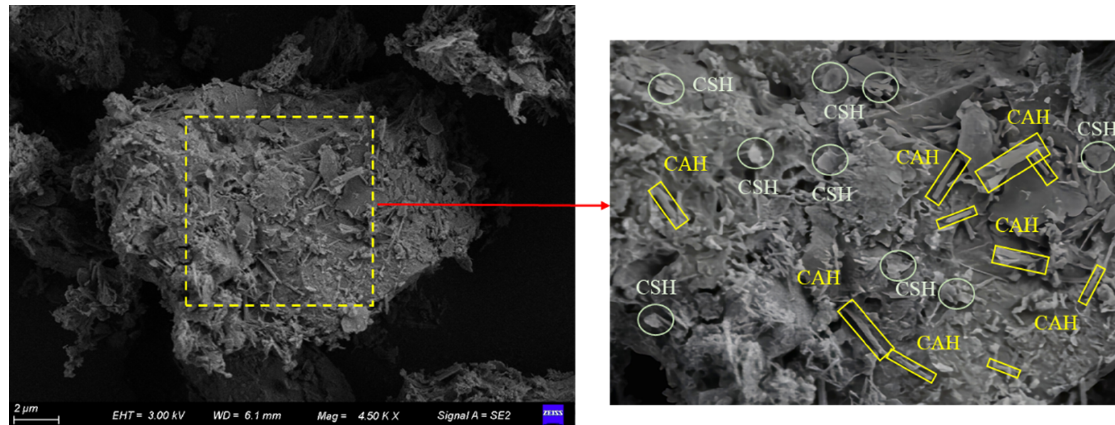
Figure 9. CAH and CSH in modified